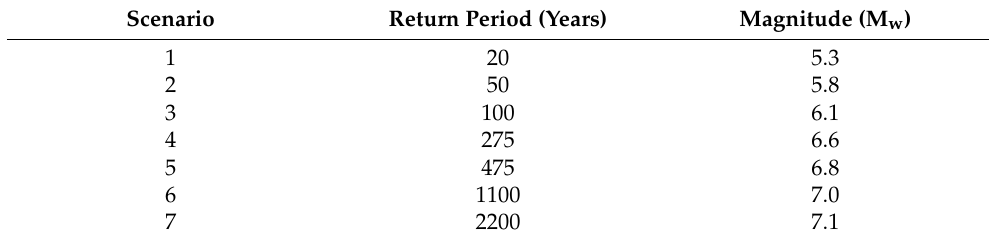
Table 6. Magnitudes and return periods associated with seven intraplate seismic